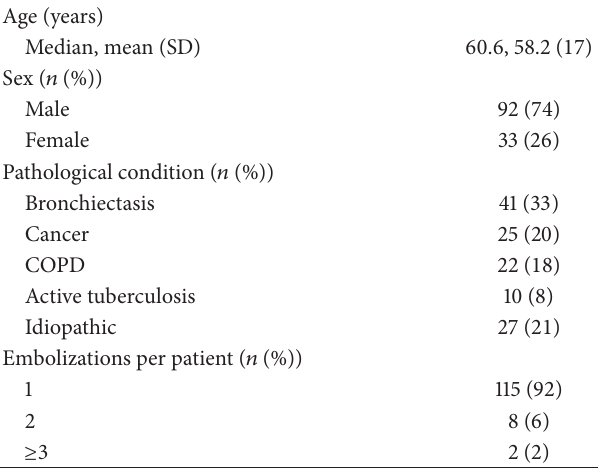
Table 1: Characteristics of the 125 subjects included in the